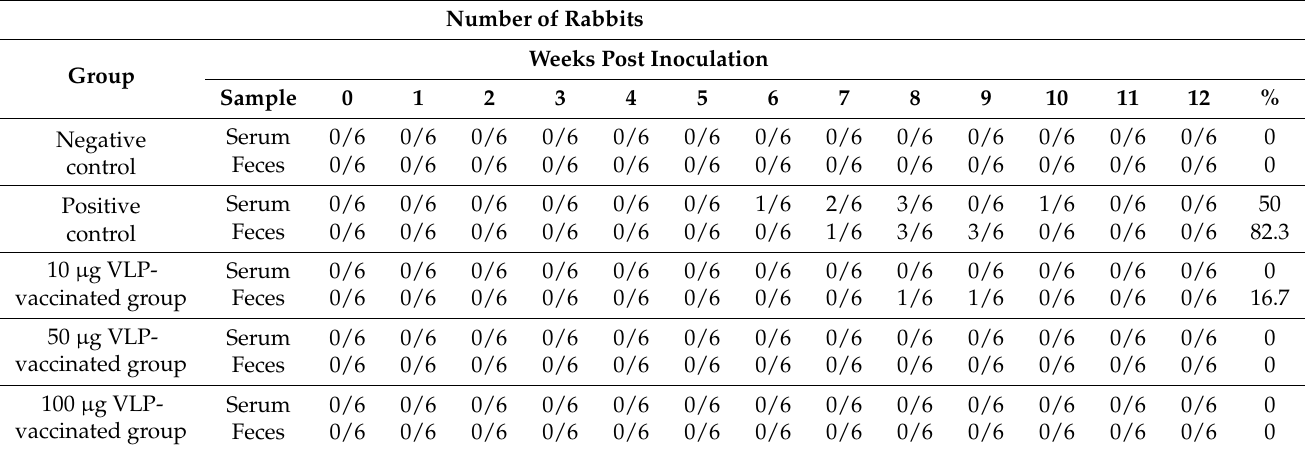
Table 2. Number of rabbits with HEV RNA detected in feces and sera in each